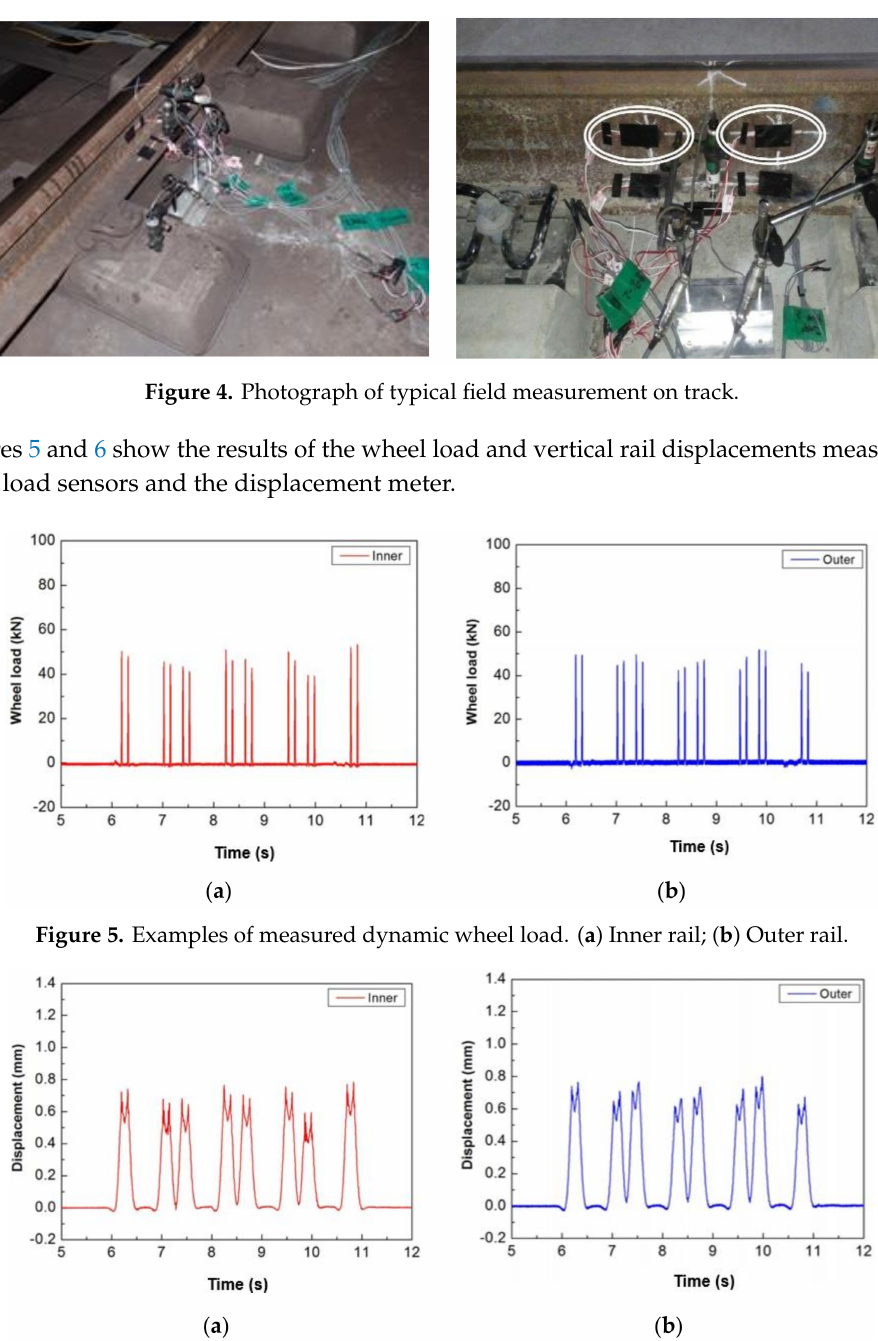
Figure 6. Examples of measured dynamic rail displacement. ( a ) Inner rail; ( b ) Outer